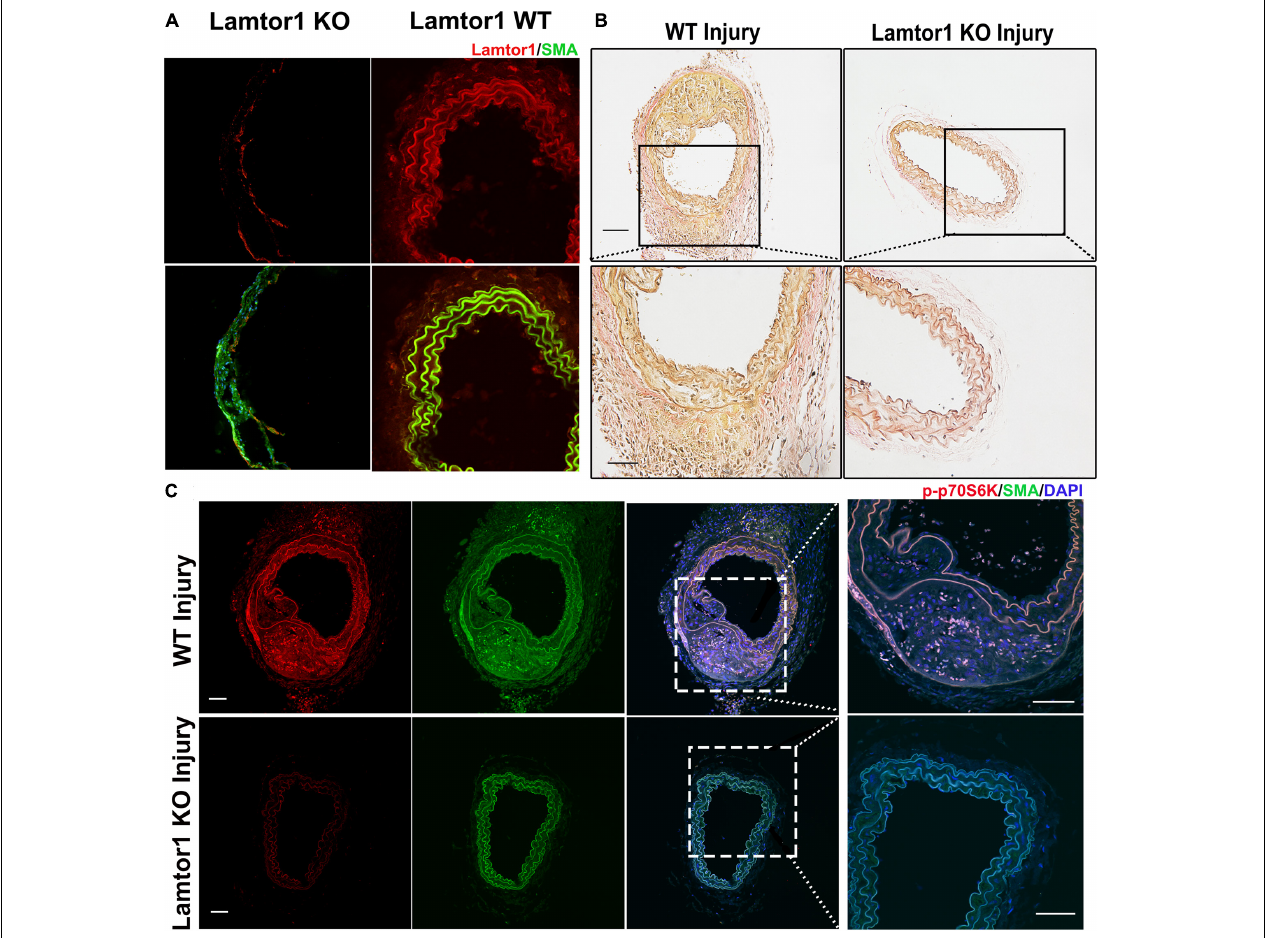
FIGURE 5 | SMC-specific Lamtor1 KO repressed mTORC1 activation and intima hyperplasia after injury. (A) Representative images of immunostaining showed that in SMC-specific Lamtor1 KO mice, Lamtor1 (red) was rarely expressed in VSMCs which was stained with SMA (green) in the wire injured carotid artery after 1-week surgery. Scale bars: 20 µ m. (B) Representative images of Elastin Van-Gieson staining revealed that neointimal formation was significantly reduced in SM-specific Lamtor1 KO mice after 1-week surgery. Scale bars: 100 µ m. (C) Representative images of immunostaining showed that p-p70S6K (red) was greatly repressed in the wire injured carotid artery of SMC-specific Lamtor1 KO mice after 1-week surgery. Nuclei are counterstained with DAPI (blue). Scale bars: 20 µ